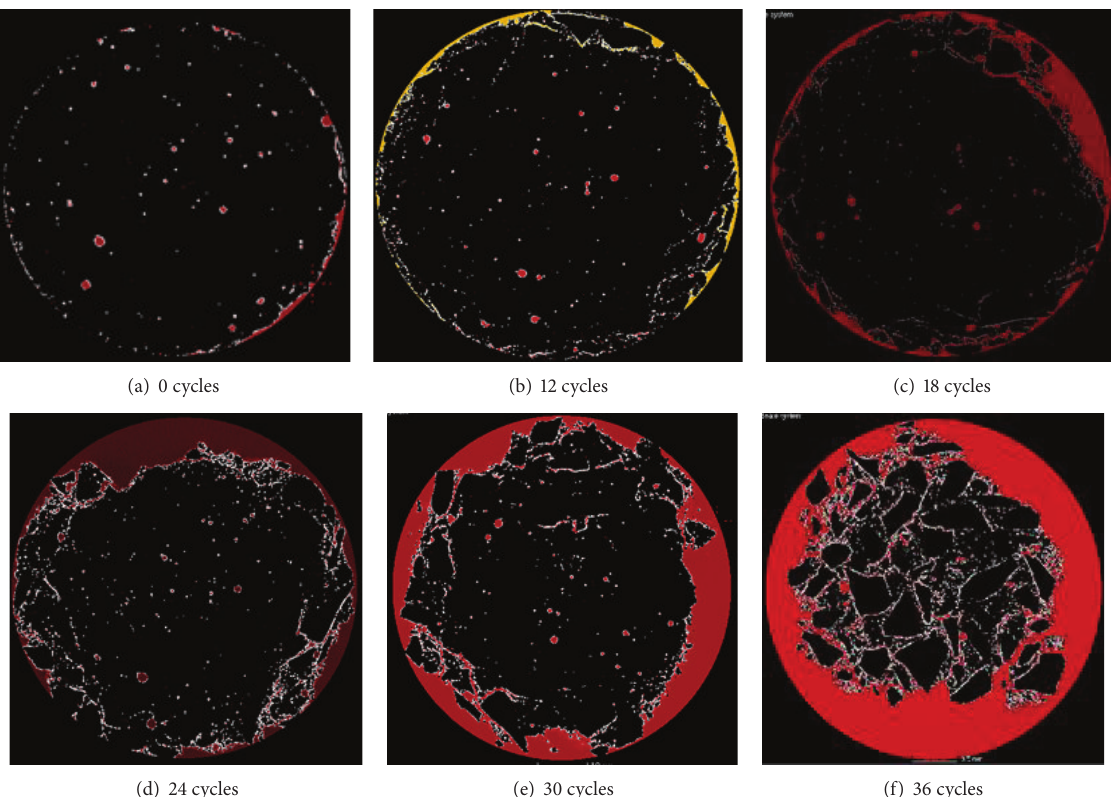
Figure 11: Damage process of the upper section under different cycles of freeze-thaw.